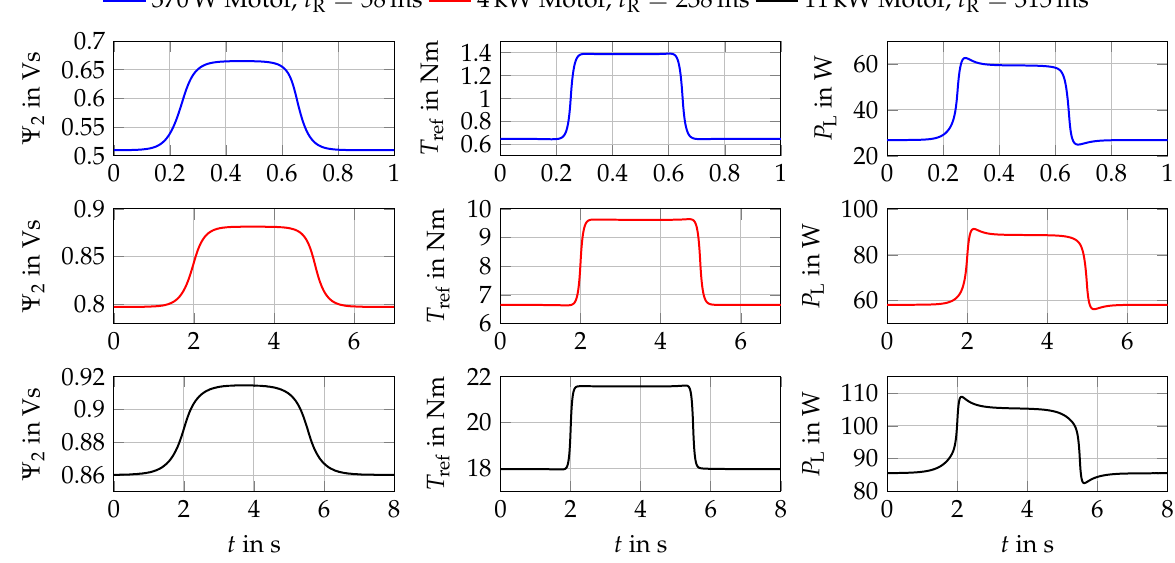
Figure 11. Simulation of optimal flux trajectories and torque for various motor